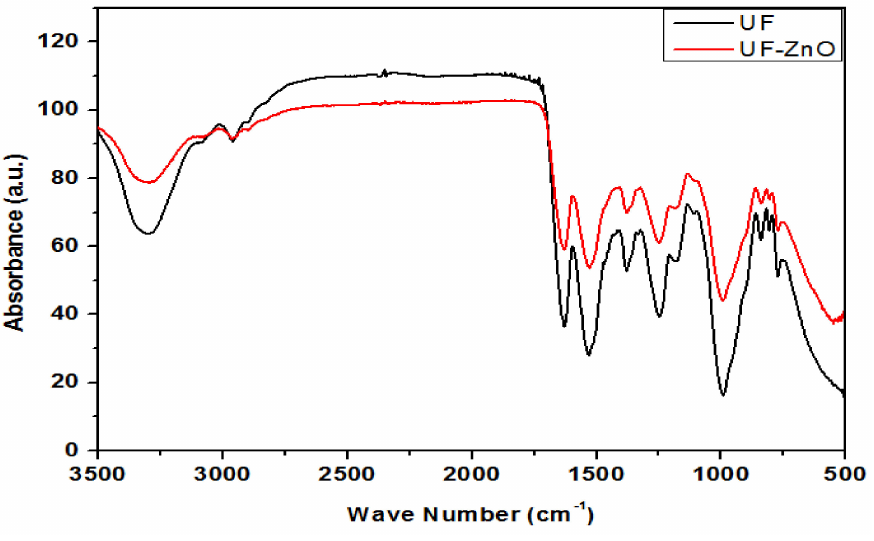
Figure 6. Fourier-transform infrared (FT-IR) spectroscopy of ZnO and UF-ZnO nanofillers. Specific bands along with their respective functional groups are summarized in Table 2.